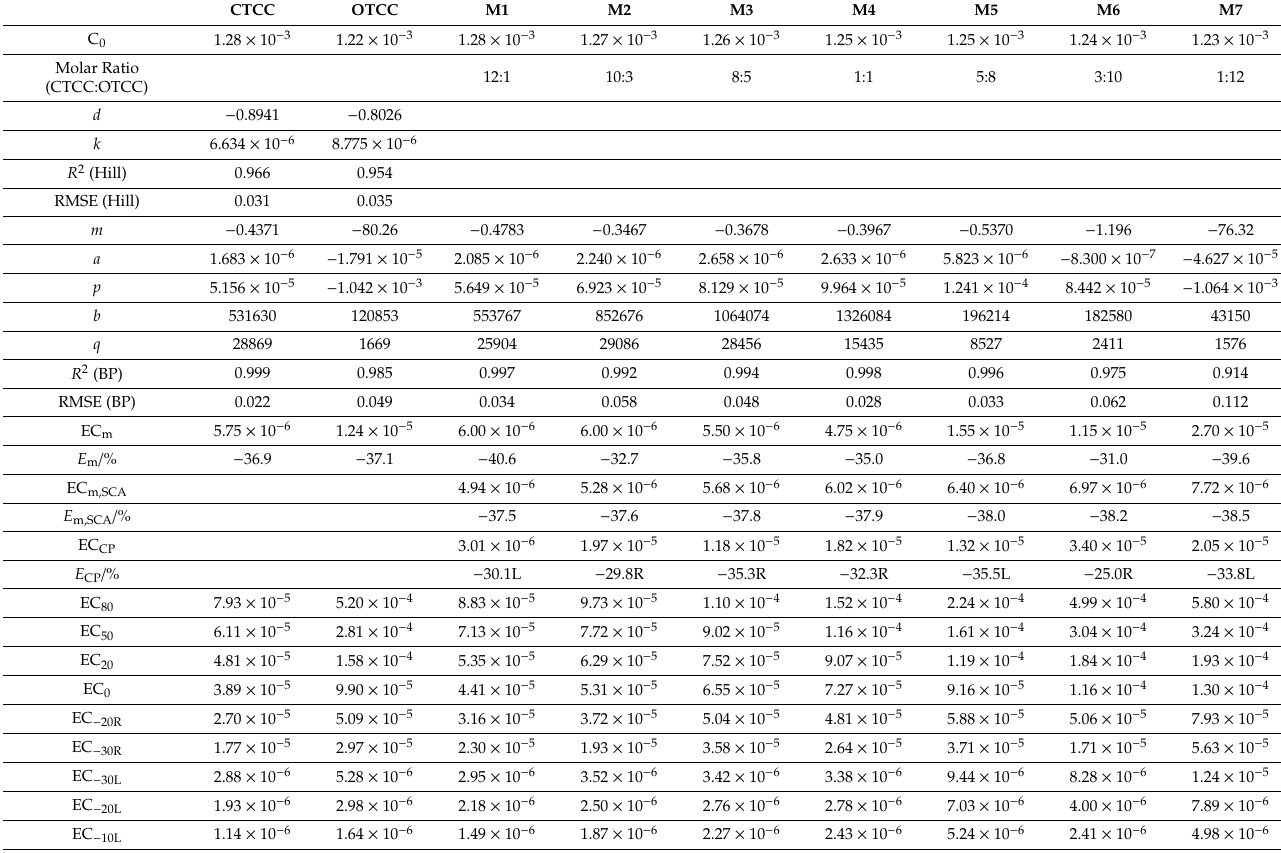
Table 1. Concentration–response model of chlortetracycline hydrochloride (CTCC), oxytetracycline hydrochloride (OTCC) and their mixtures inhibiting Allivibrio fischeri and related